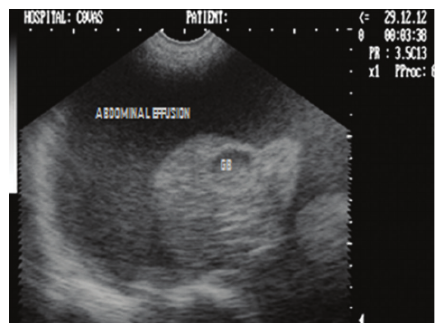
Figure 19: Sonograph (2D) in transverse scan showing hyperechoic liver lobe and cholecystitis with inspissated bile in gall bladder (GB) in a 7-year-old intact Pomeranian male